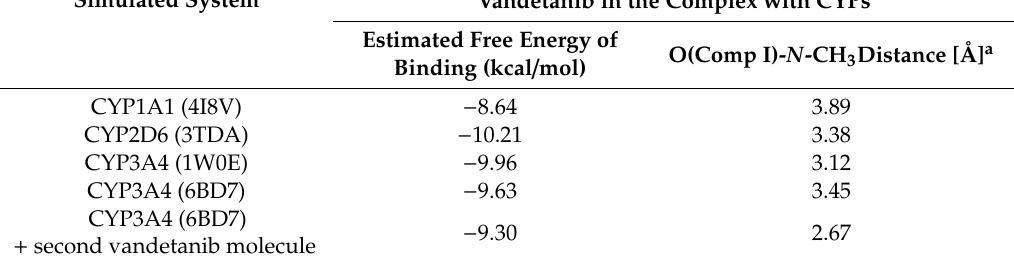
Table 4. The predicted binding free energies and distances facilitating N -demethylation of vandetanib bound in selected CYPs.